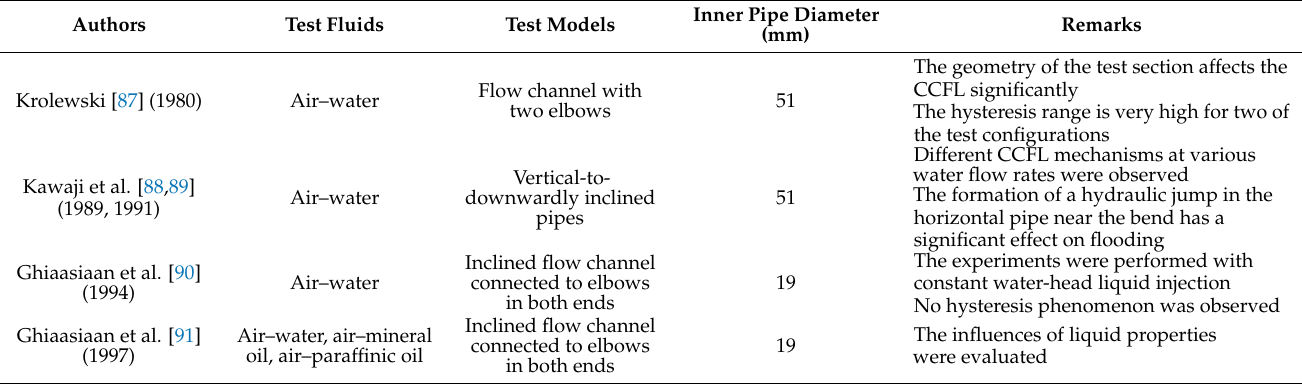
Table 7. Summary of the experimental investigations on the CCFL in other flow channels with el- bows.